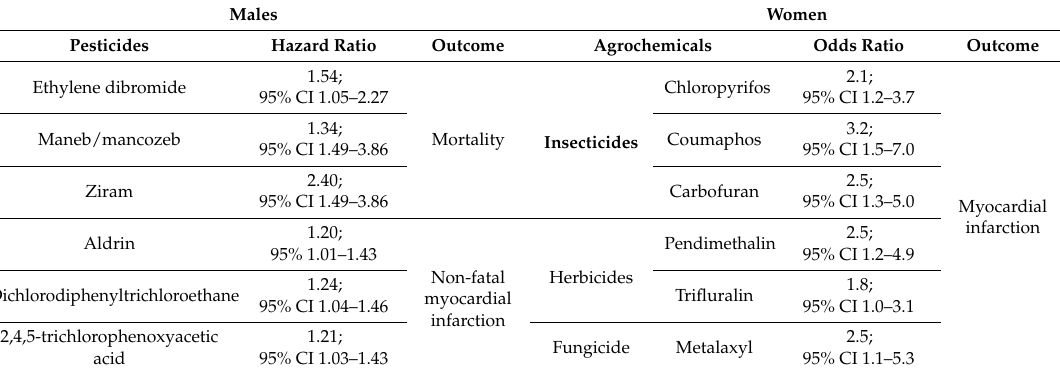
Table 3. The summarized association of pesticides usage and non-fatal myocardial infarction non-fatal incidence and mortality among male and female pesticides applicators, Agricultural Health Study, 1993–2006